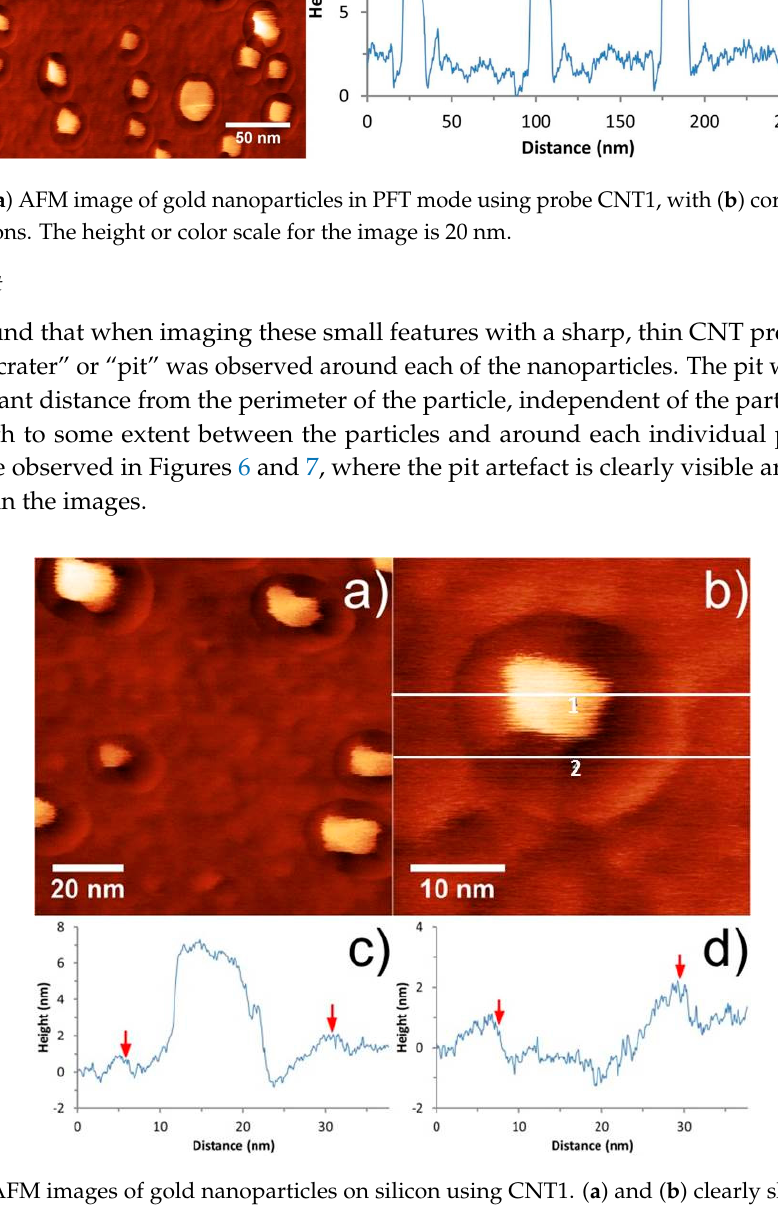
Figure 6. AFM image of gold nanoparticles in PFT mode using probe CNT1, with corresponding cross sections. The height or color scale for the image is 20 nm.